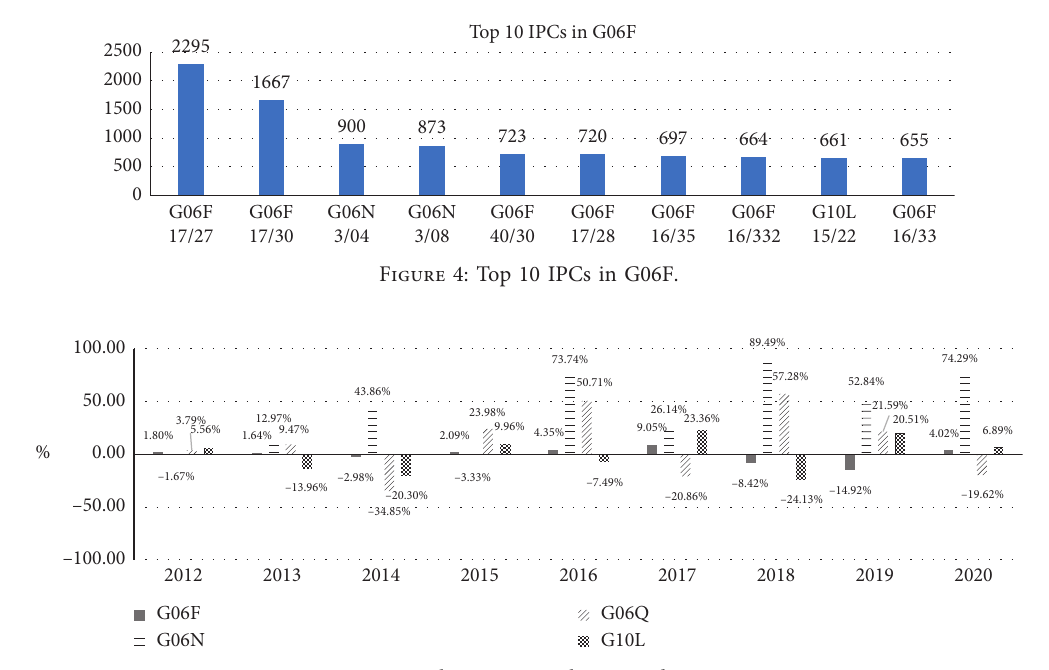
Figure 5: Annual patent growth rate under top